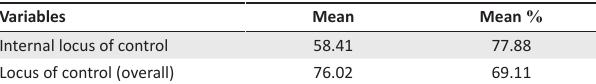
TABLE 1: Descriptive statistics.